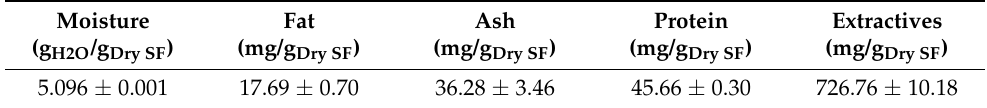
Table 3. Saffron flowers proximate composition.